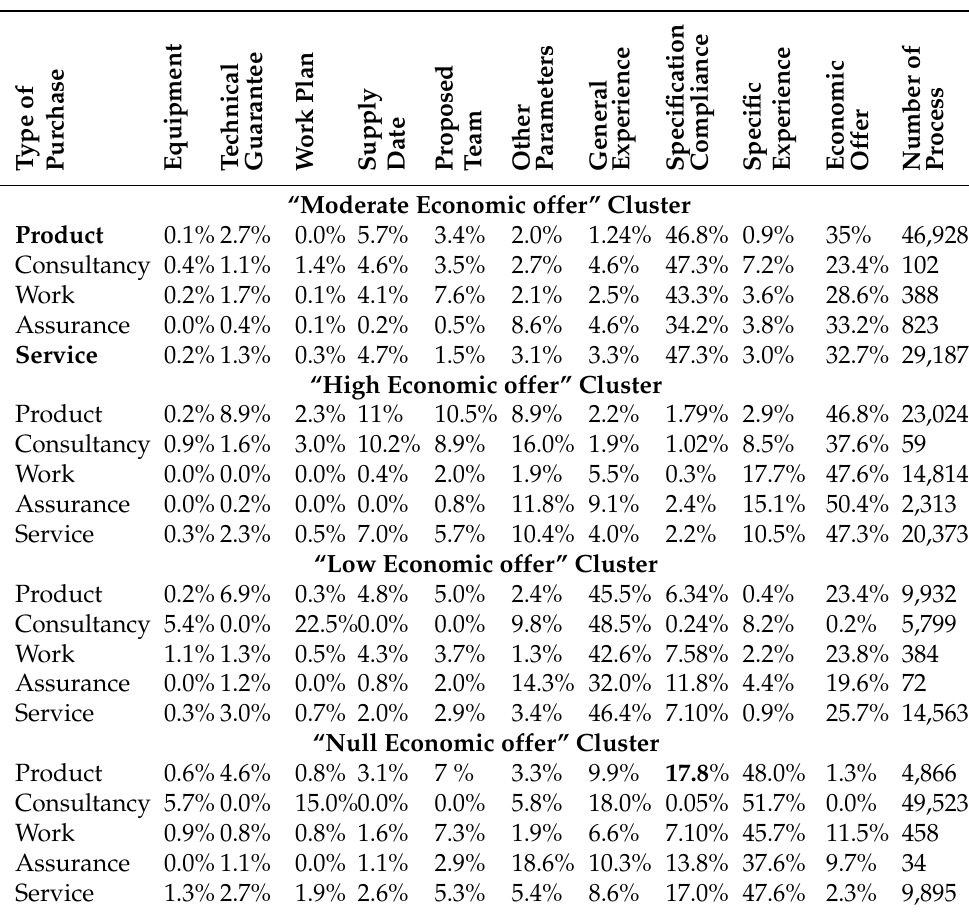
Table 4. Clusters related type of